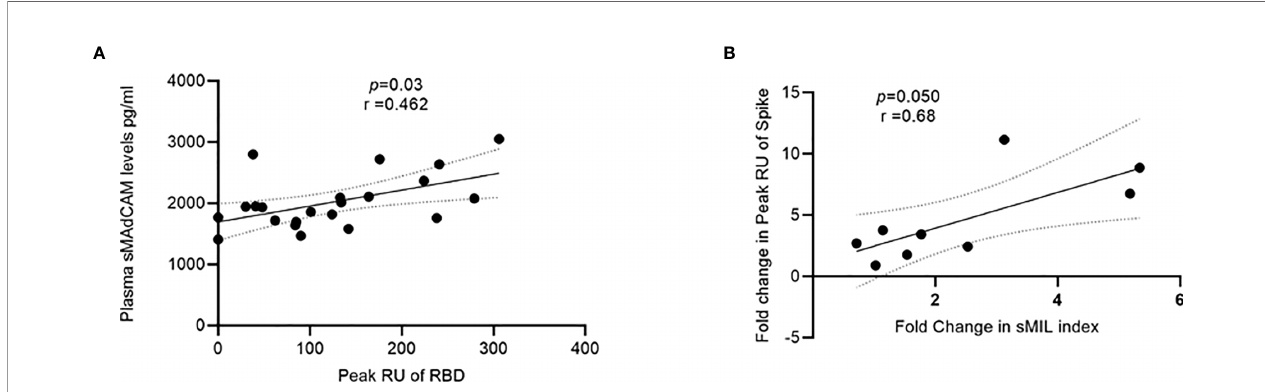
FIGURE 5 | Association of sMAdCAM levels/sMIL index and virus speci fi c binding in plasma. (A) Association of plasma MAdCAM levels with peak RU (association rate) of RBD binding among convalescent study participants. (B) Association of fold change between peak RU for spike and sMIL index among study participants (n = 9 out of 11) who were followed up. Fold change was calculated by dividing day 7 values with those of day 0. Fold change in peak RU of two individuals could not be calculated as day 0 values were undetectable (zero). Correlation analysis performed using non-parametric Spearman rank correlation test. r indicates strength of correlation; p indicates signi fi